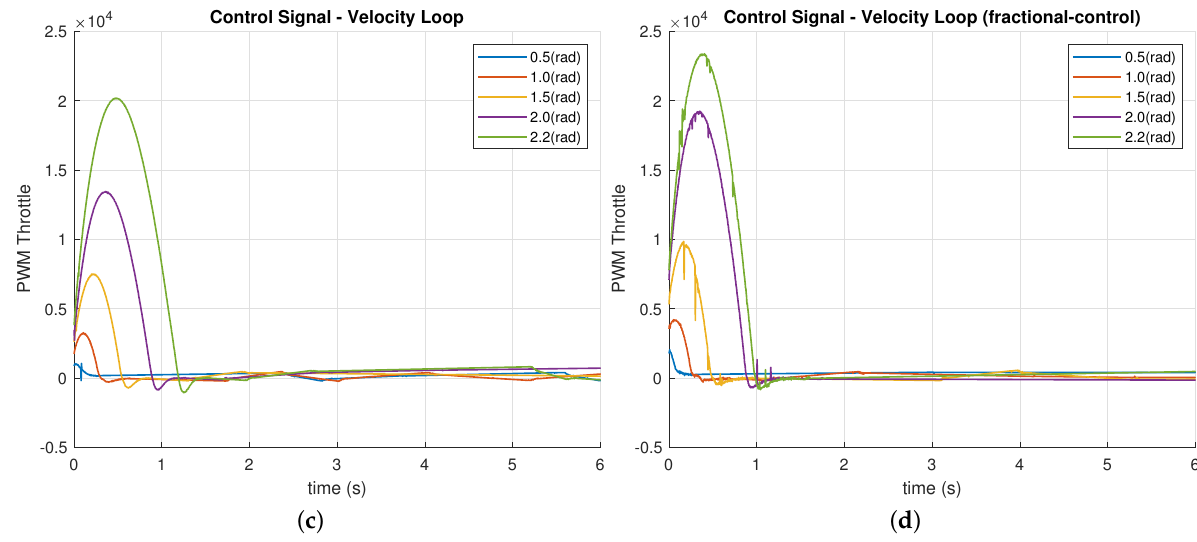
Figure 21. Control signals. ( a ) Position loop control signals with integer controller. ( b ) Position loop control signals with fractional controller. ( c ) Velocity loop control signals with Integer controller. ( d ) Velocity loop control signals with fractional controller.